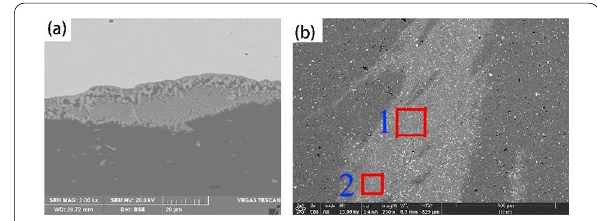
Table 1 EDX quantification results (wt%) indicated in Figure 4 Location